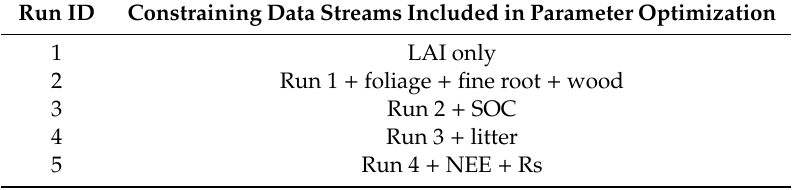
Table 1. Multi-source data optimization experiments based on DALEC (Data Assimilation Linked Ecosystem Carbon).